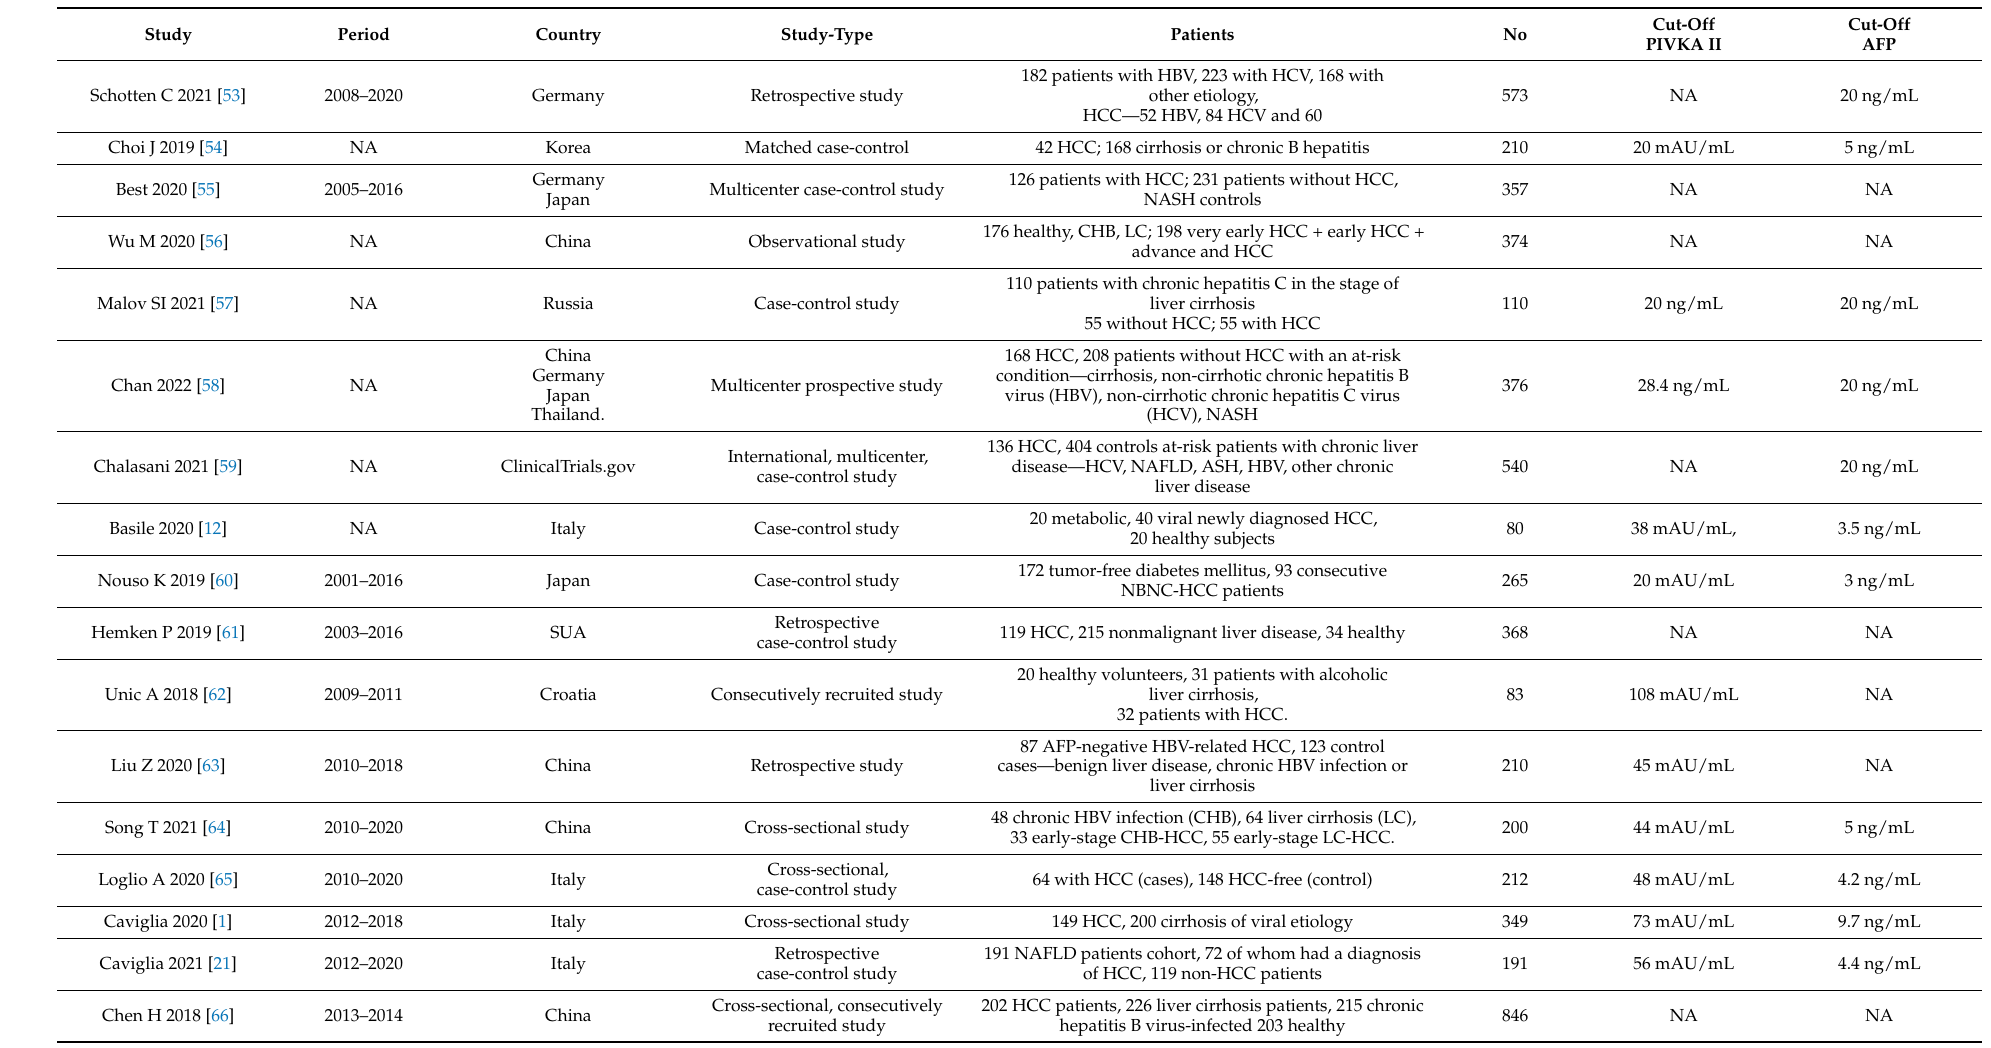
Table 1. All studies included in meta-analysis (for HCC discrimination or for early HCC